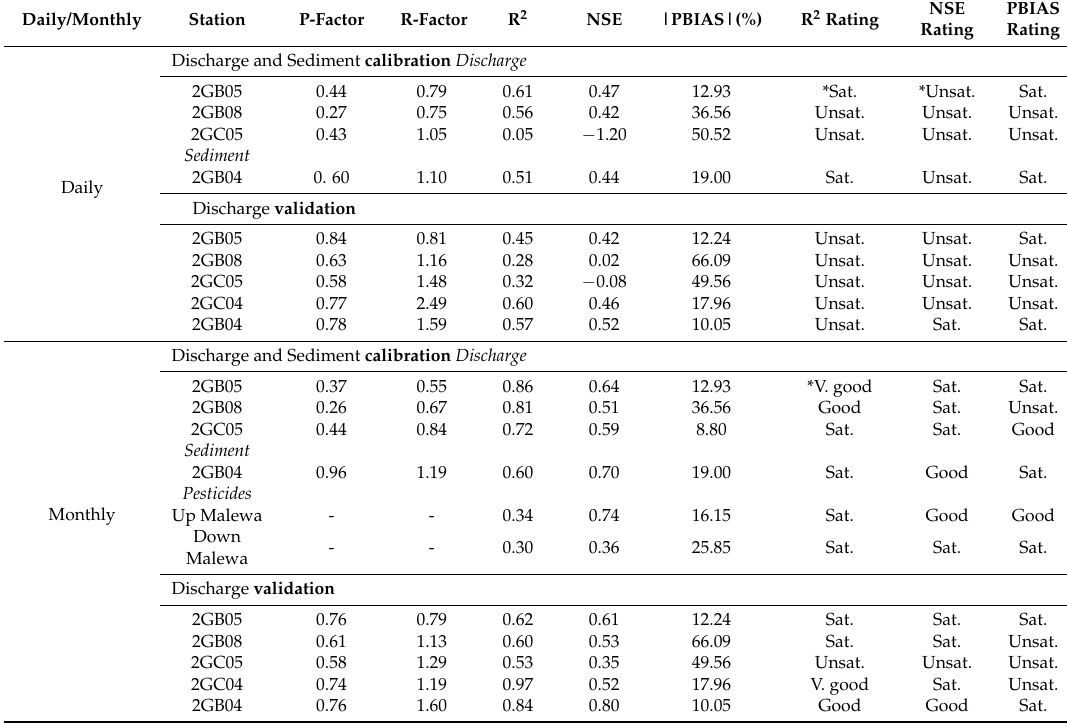
Table 2. Model performance measures for monthly and daily calibrations (2007–2012) and validations (2013–2017). The metrics were rated based on Moriasi et al. (2015) and Chen et al. (2017) [6,31].